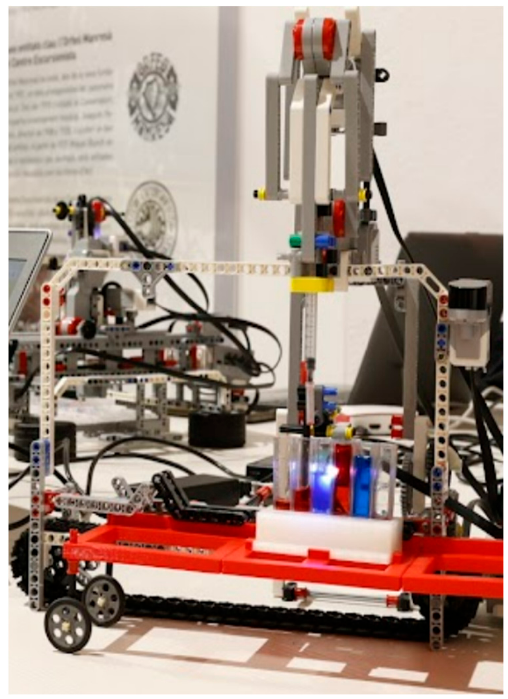
Figure 1. Lab Qui-Bot [11,21,27] with the RGB sensor activated (Front view).